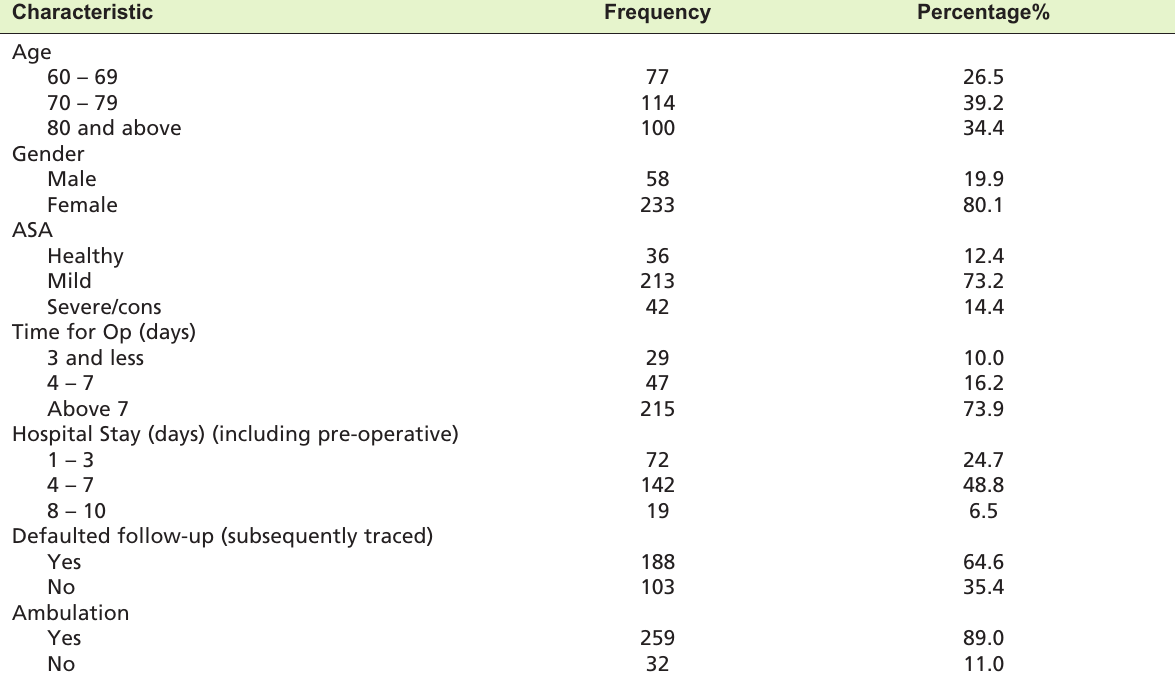
Demographic and clinical characteristics of THR patients (n=291) Table I: